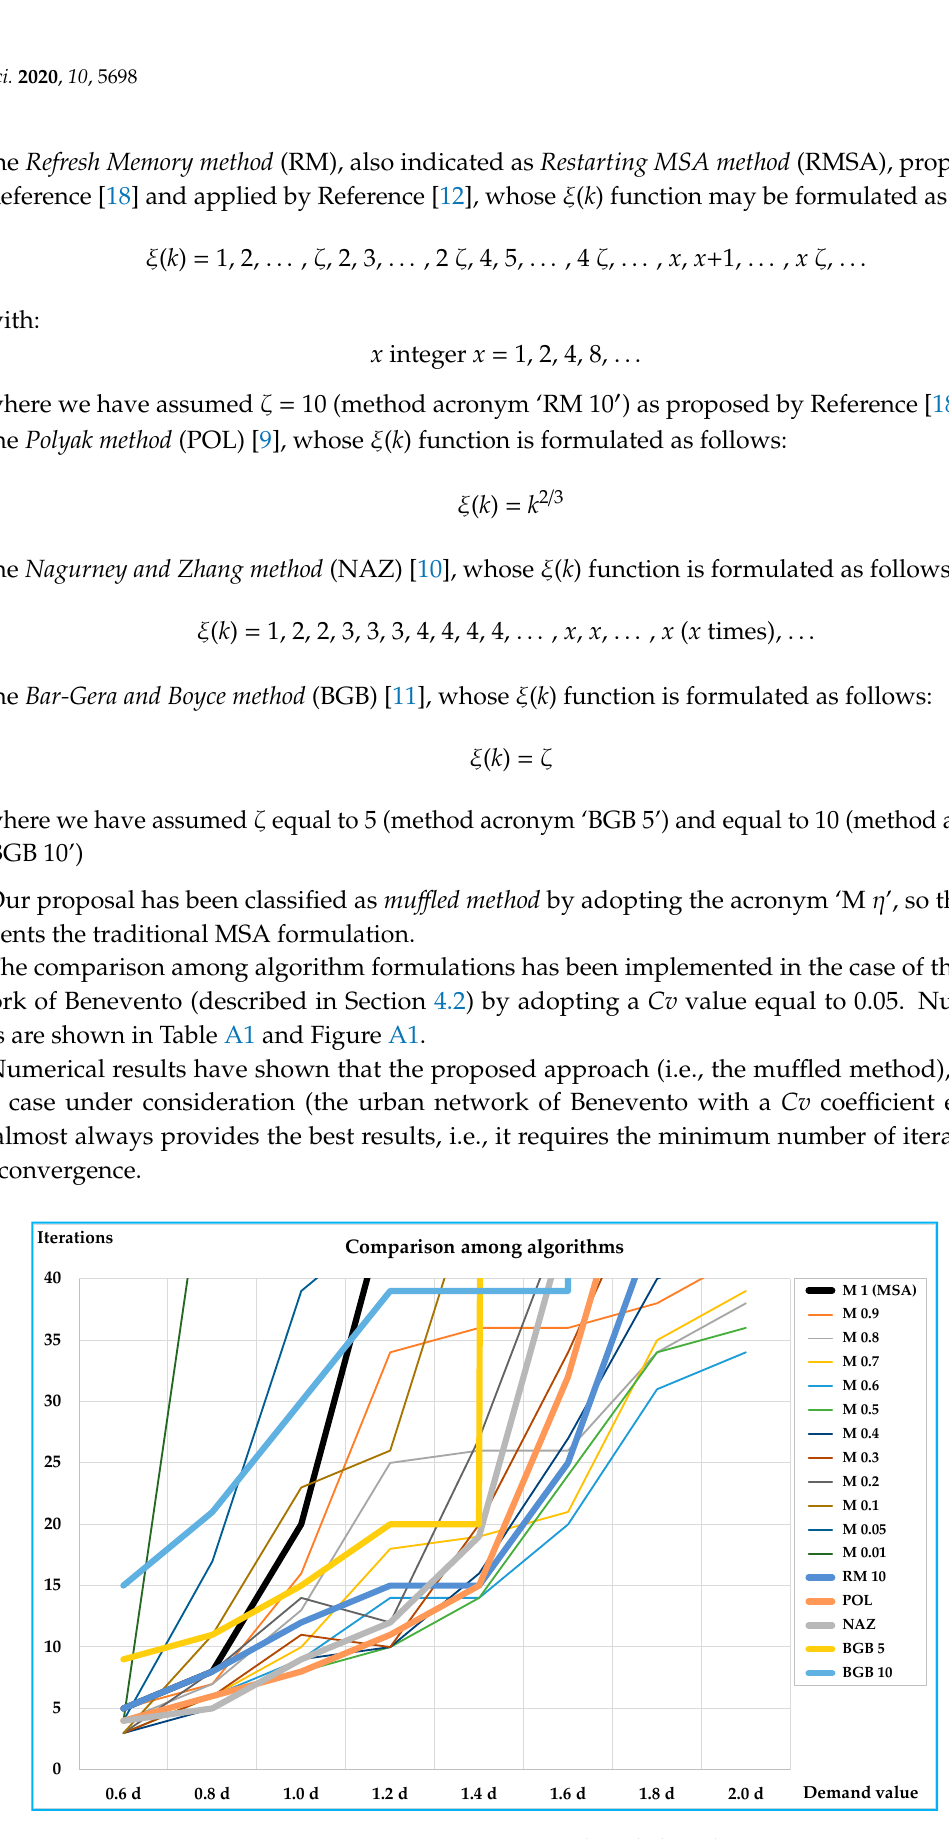
Figure A1. Comparison among MSA-based algorithms.